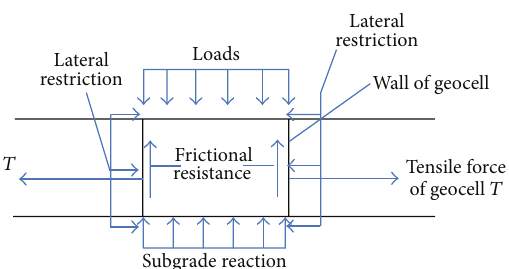
Figure 2: Lateral resistance effect of geocell